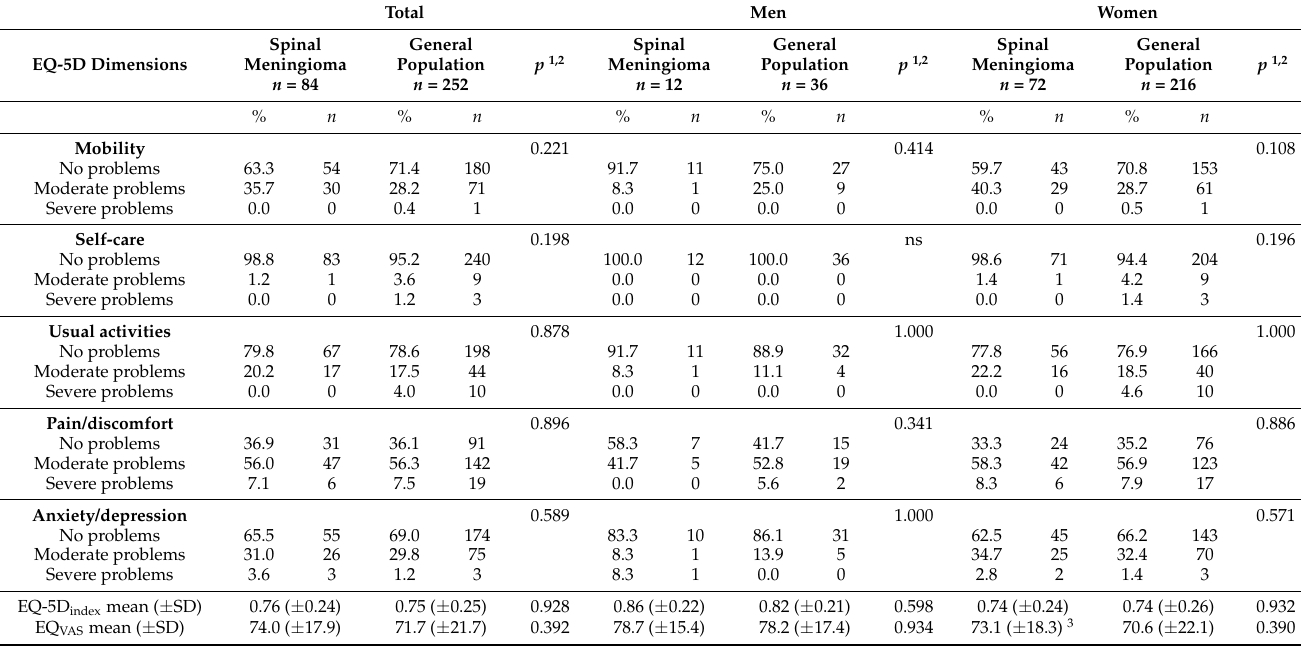
Table 2. Percentage (number) of participants reporting no, moderate or severe problems in EQ-5D dimensions, EQ-5D index , and EQ VAS , spinal meningioma sample and general population